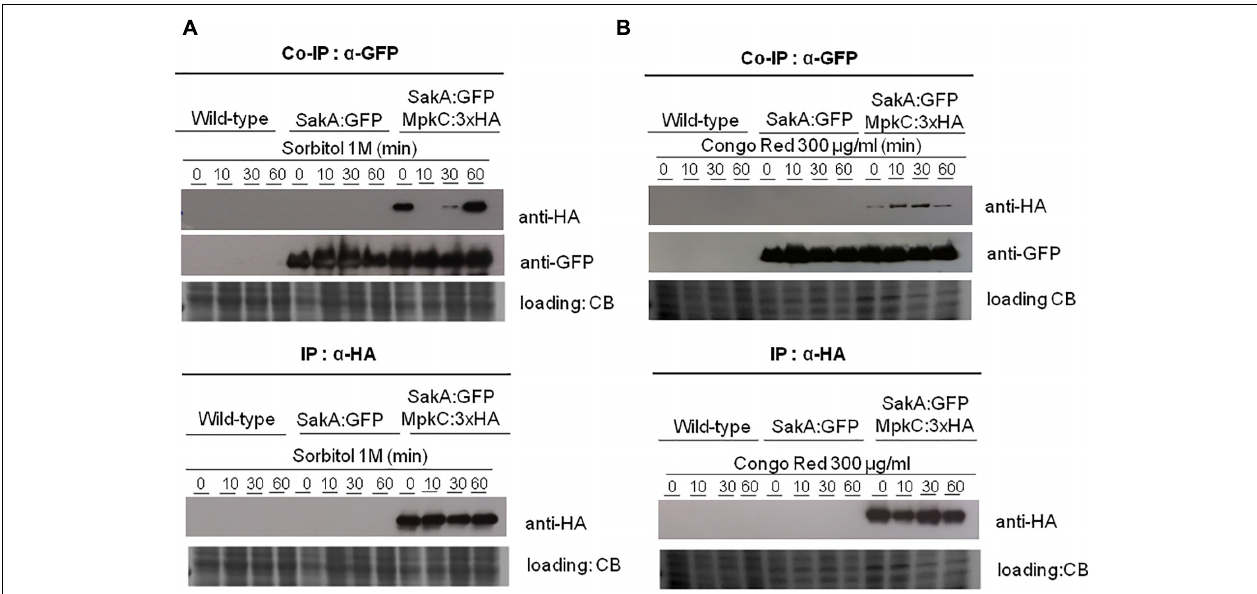
FIGURE 2 | Co-immunoprecipitation (Co-IP) of SakA:GFP and MpkC:3xHA. (A) Verification of association between SakA:GFP and MpkC:3xHA by Co-IP. Affinity purification assays from GFP-tagged SakA strain in the background of 3xHA-tagged MpkC were performed with GFP-Trap and anti-HA beads to verify interactions upon sorbitol (A) and cell wall stresses (B ). The coimmunoprecipitated proteins were analyzed by the indicated antibodies. CB, coomassie blue staining.